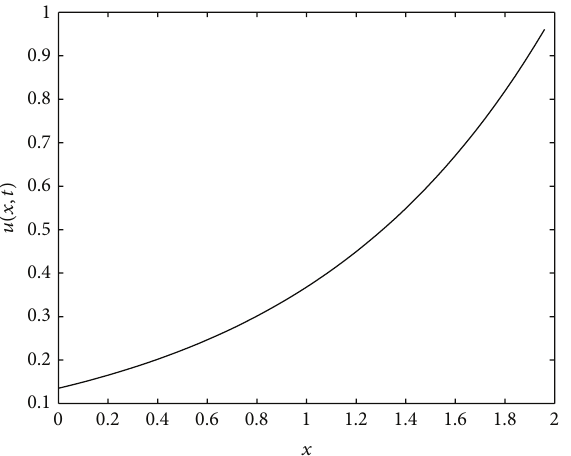
Figure 2: Plot of 𝑢(𝑥,𝑡) with respect to 𝑥 , 𝑥 ∈ [0,2] at 𝑡 = 1 for Examples 1 and 3.